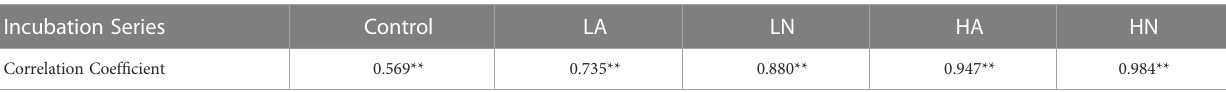
TABLE 2 Results of a correlation analysis between Phaeodactylum tricornutum abundance and the phycosphere bacterial abundance in different culture systems. Incubation